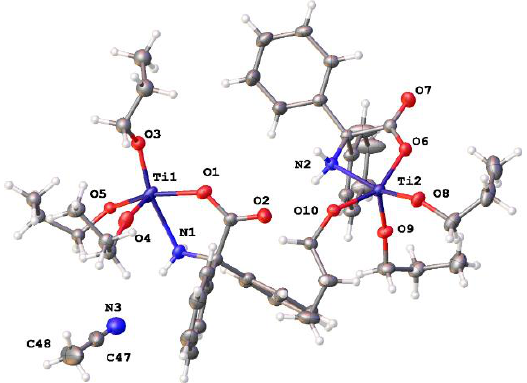
Figure 7. Asymmetric unit of 7 with atoms drawn as 50% probability ellipsoids. For clarity, minor disorder is not shown. Selected bond lengths (Å) and bond angles ( o ): Ti(1)-Ti(1i) 3.2815(5), Ti(1)-